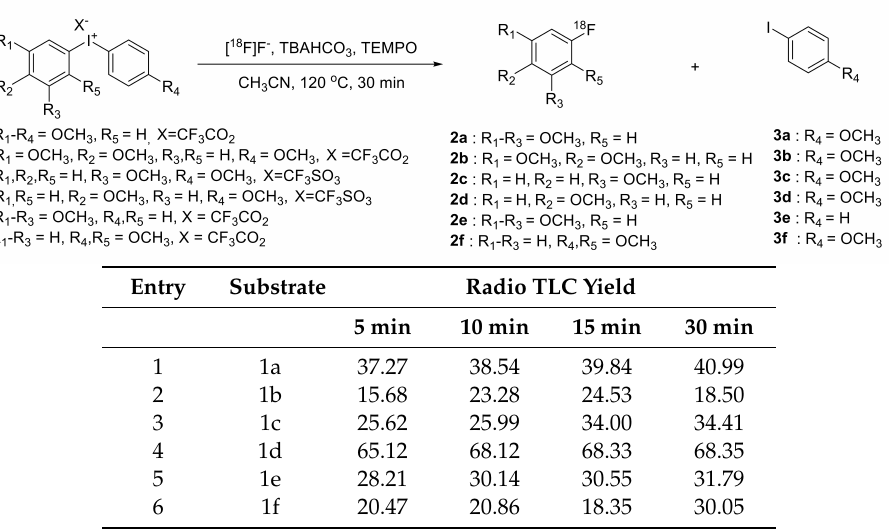
Table 3. [ 18 F]Fluorination of various diaryliodonium salts. Fluorination may occur at the ring with more electron-donating substituents, and subsequently with larger electron density, in contrast to what is predicted by substituent inductive e ff ects.